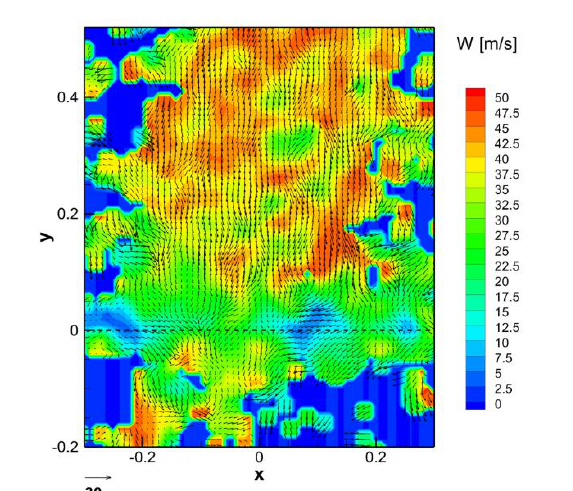
Fig. 16. Example of the instantaneous velocity field. Re = 1.5M.